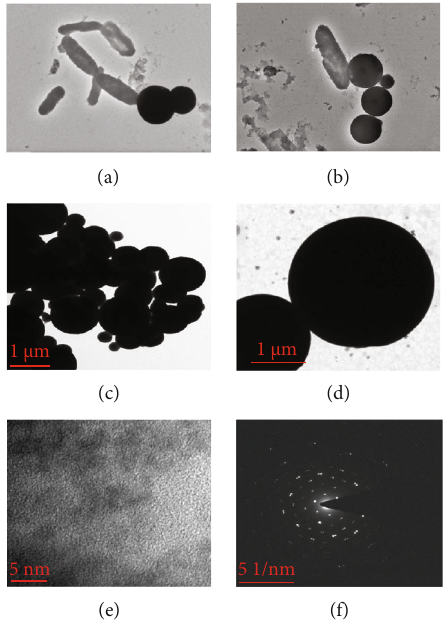
Figure 5: TEM micrographs of (a – d) CFA FS, (e) d-spacing, (f) and SAED